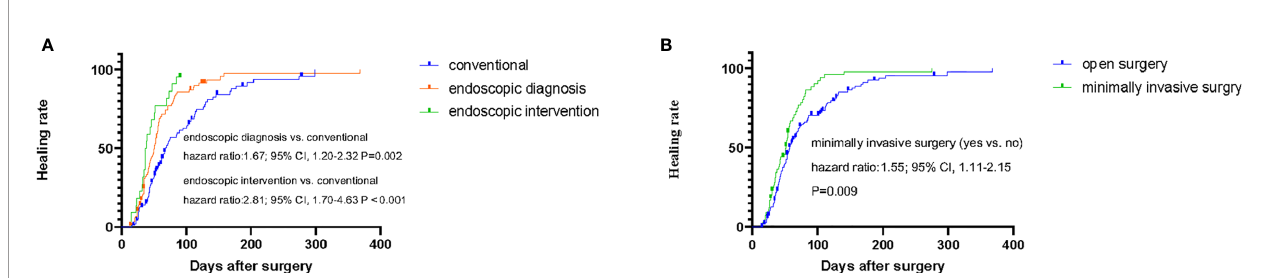
CI, Con fi dence